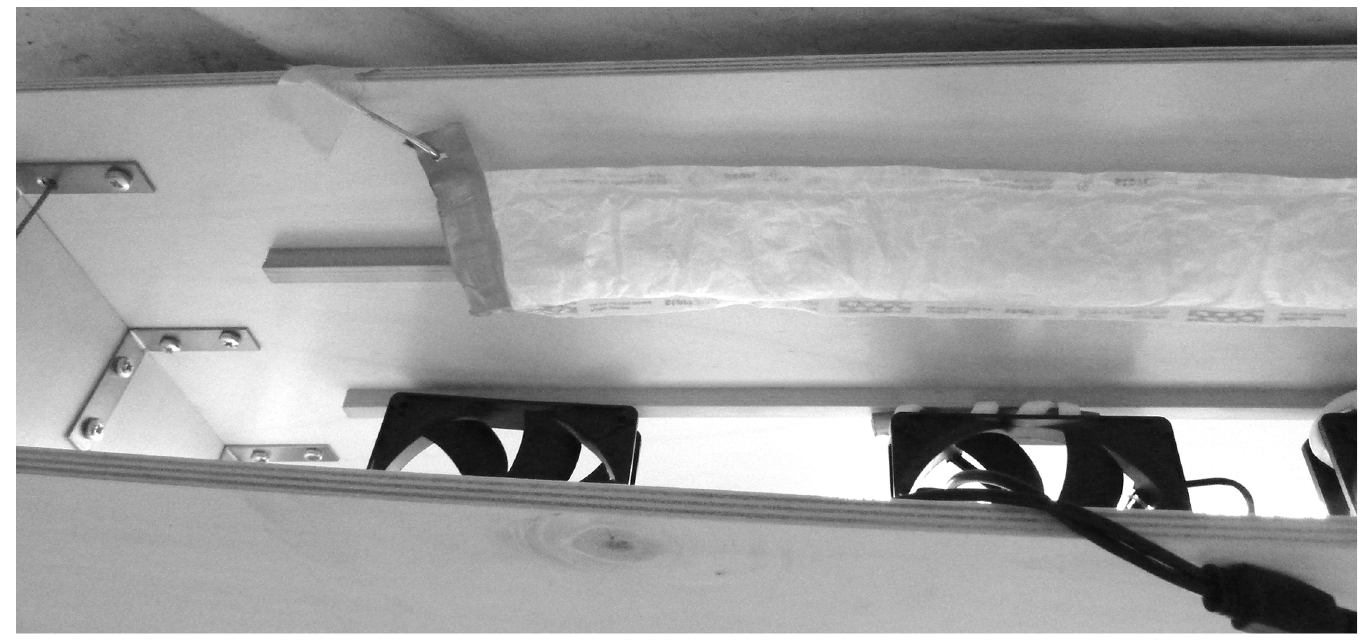
Fig 2. Stericlin repellent sachet attached to the FFS with the permeable side facing the